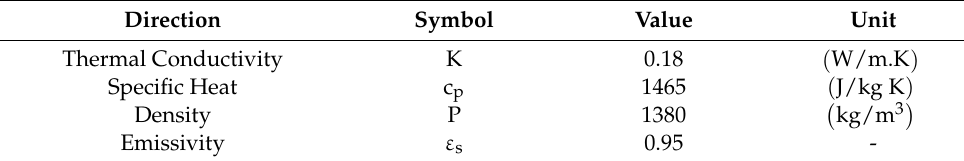
(cid:0) (cid:1) kg/m 3